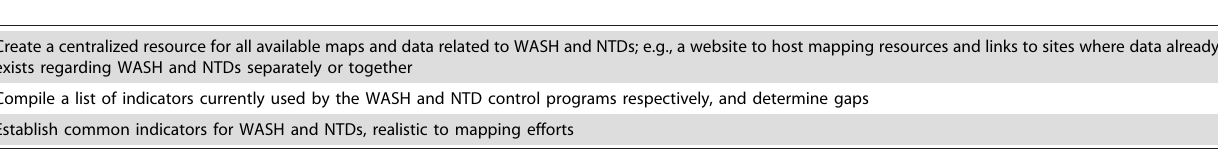
Table 6. Opportunities and next steps in mapping, data collection, and monitoring.